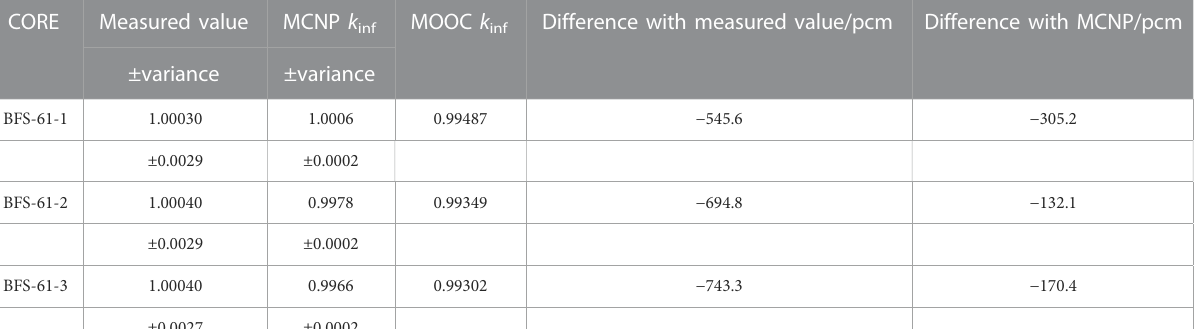
TABLE 5 Summary of the eigenvalue results of BFS-61.